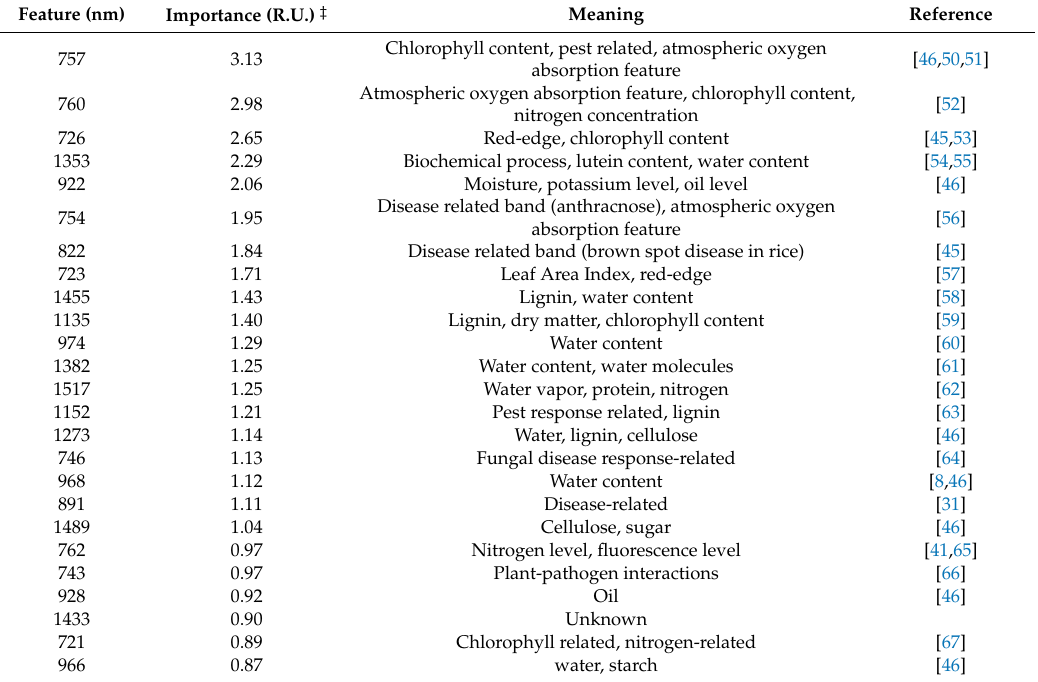
Table 3. Important wavelengths in the selected random forest architecture and their physiological meaning according to the literature. (R.U.) stands for Relative